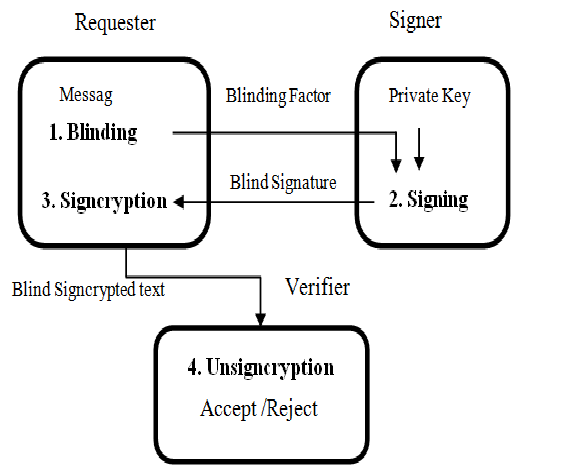
Fig. 3: Data Flow Mechanism in Blind Signcryption Table 1: Symbols or Parameters Description